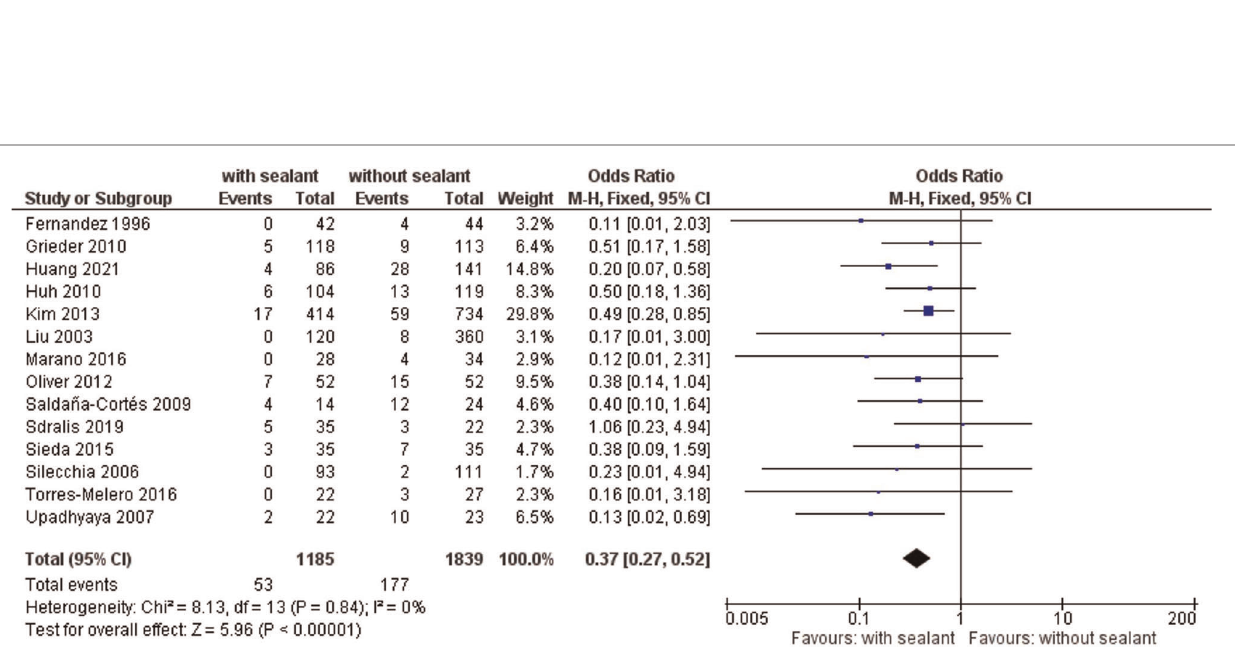
FIGURE 2 | Fixed-effects meta-analysis for the postoperative anastomotic leakage rate in the intervention (coated or reinforced anastomoses) and control group. The forest plot of all studies is included.